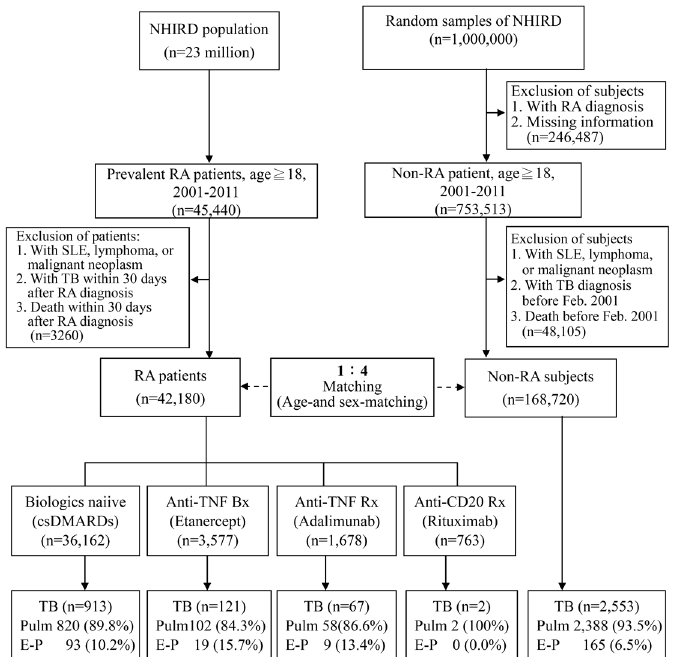
Fig 1. Flow chart of case selection in this study. The rheumatoid arthritis (RA) patients, and age- and sex- matched non-RA control subjects were selected from the Taiwan National Health Insurance research database